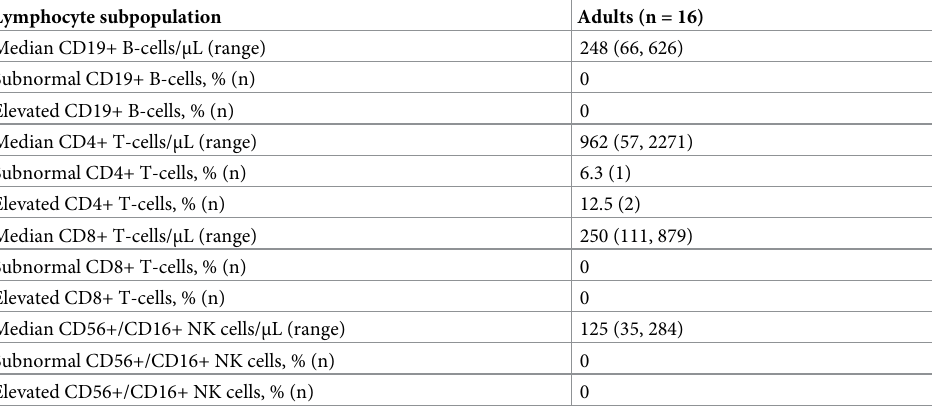
Table 3. Blood lymphocyte subpopulations in 16 adults with IgGSD and subnormal IgG2 a . Lymphocyte subpopulation Adults (n =